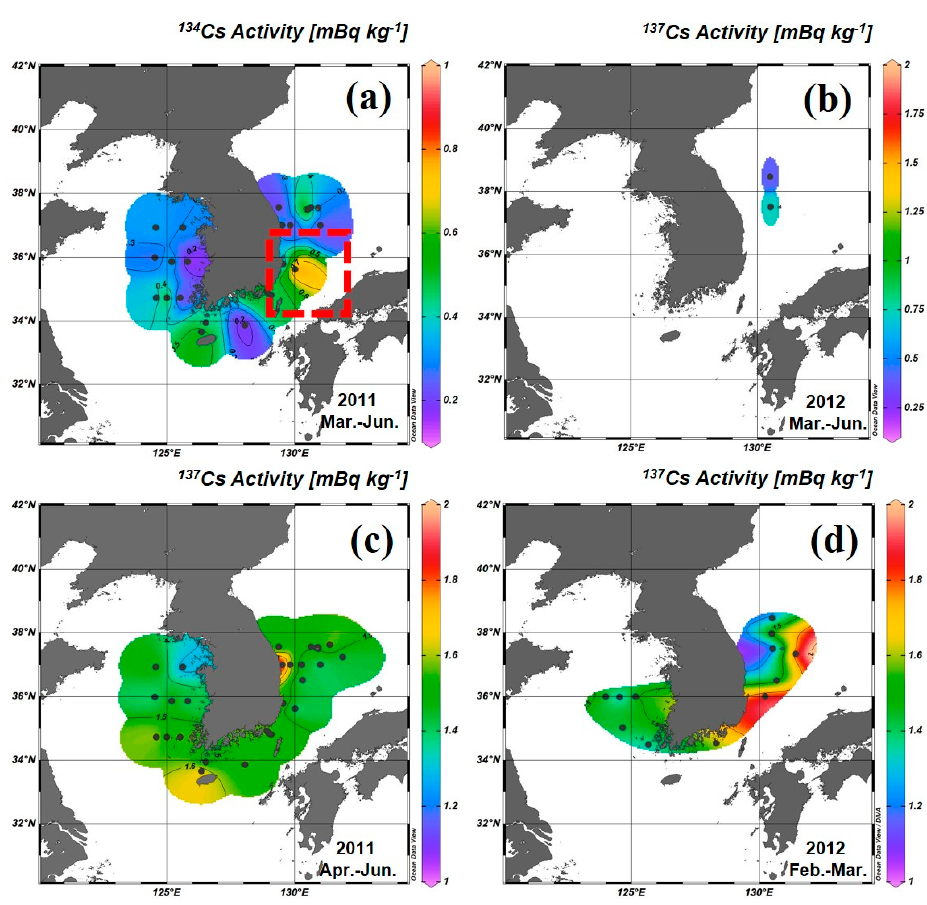
Figure 2. The spatial distributions of the 134 Cs (( a , b ), upper panel) and 137 Cs (( c , d ), lower panel) activities in the Korean seas from 2011 (( a , c )) to 2012 (( b , d )). The red square indicates the region (Korean Strait) where the sample (data) was collected on 29–30 March 2011.